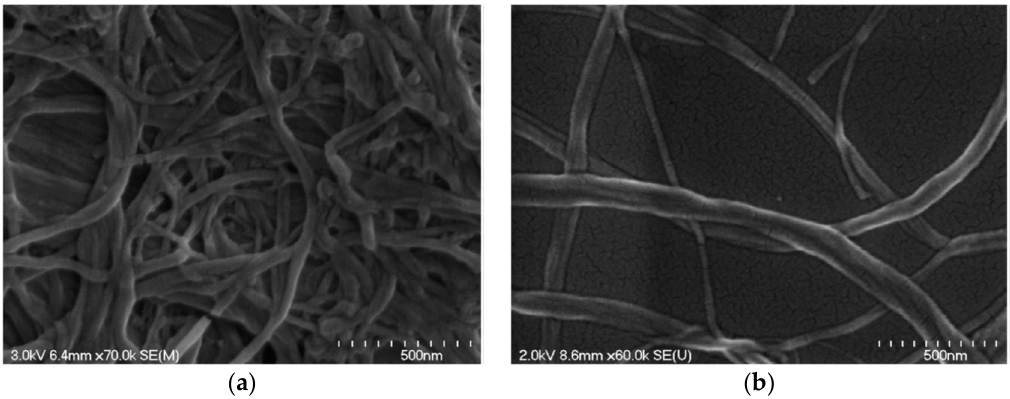
Figure 5. Scanning electron microscopy (SEM) images of ( a ) cellulose filament (CF) network and ( b ) individual CF fibril. Reproduced from [21], with permission from American Society of Civil Engineers, 2018.